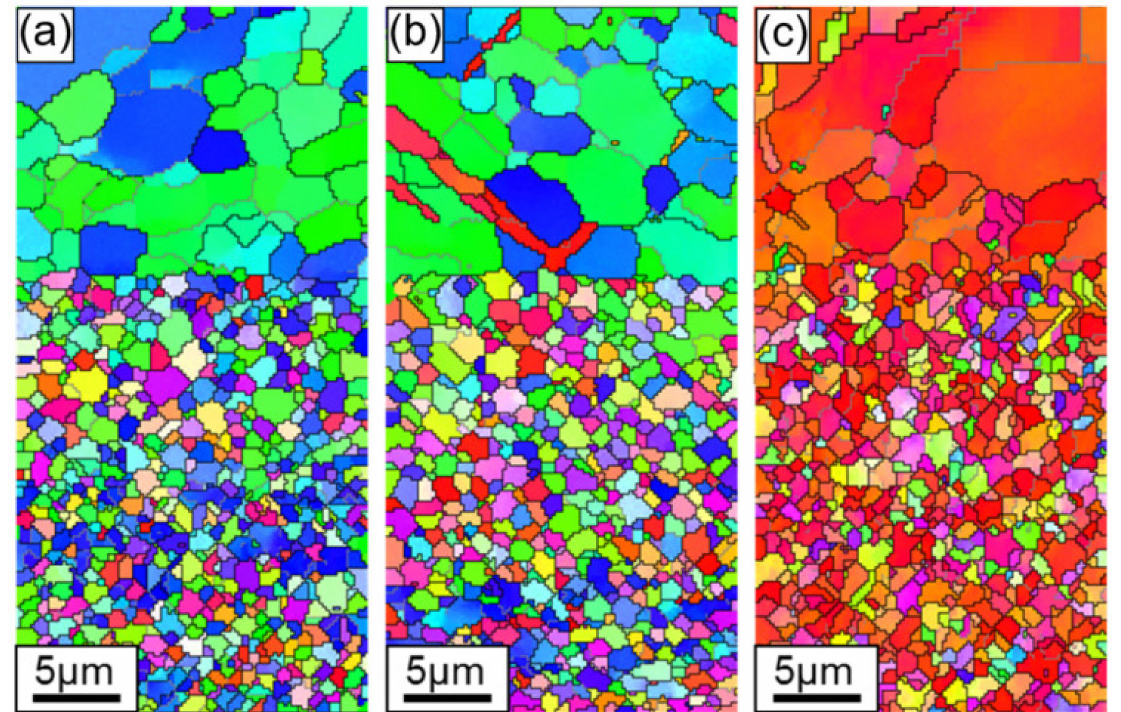
Figure 10. EBSD orientation maps showing microstructure in the interface zone along the extrusion direction of the ZK60 / WE43 composite rod to di ff erent true strain levels: ( a ) initial undeformed state (0%), ( b ) compressive yield point (1.1%), and ( c ) compressive “ultimate” point (9.4%). The compressive direction (i.e., ED) is perpendicular to the maps. The colors in the maps represent the local crystal lattice frame with respect to the ED / compressive direction according to the color legend shown in Figures 8 and